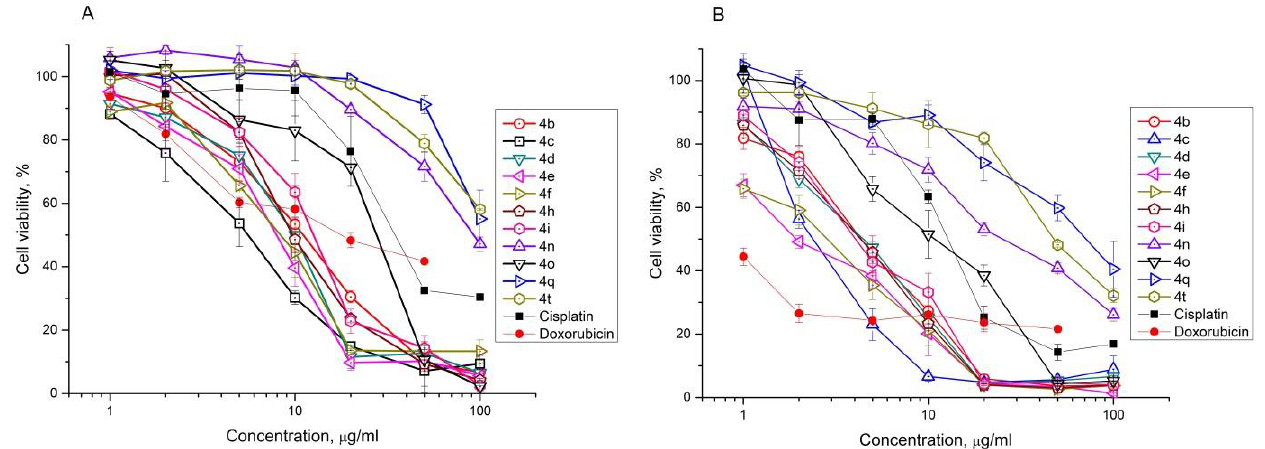
Figure 1. Cytotoxicity of selected 3-azaspiro[bicyclo[3.1.0]hexane-2,5′-pyrimidines] 4 against K562 cell line for 24 h ( A ) and 72 h ( B ).